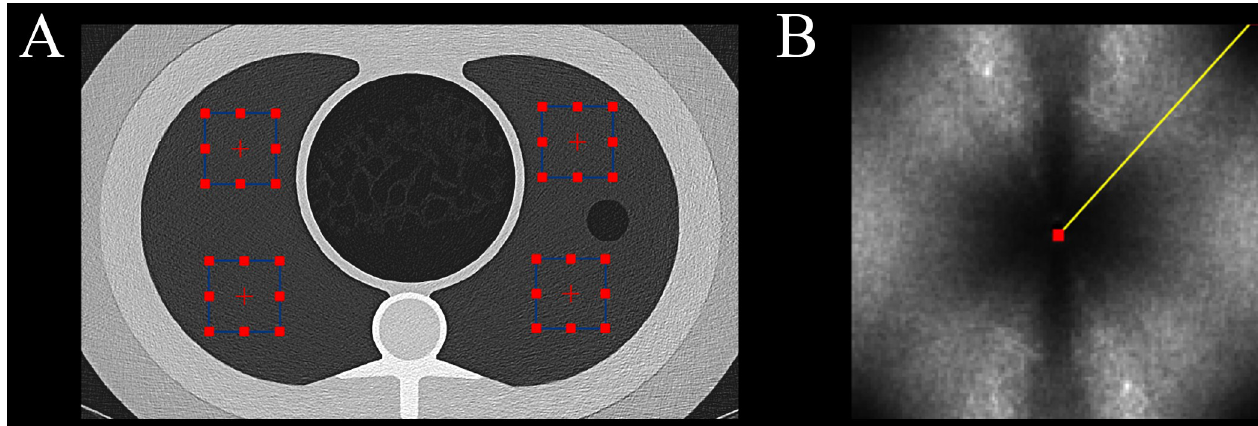
Fig 2. Measurement of nNPS. (A) Image demonstrating the measurement principle of the nNPS. Four square ROIs were placed at different positions in the uniformly aerated lungs of the phantom. Measurements were performed on 60 slices in each dataset. (B) 2D nNPS shapes were qualitatively assessed. The overall frequency content was compared using a 1D profile (yellow line) along the diagonal of the 2D nNPS.